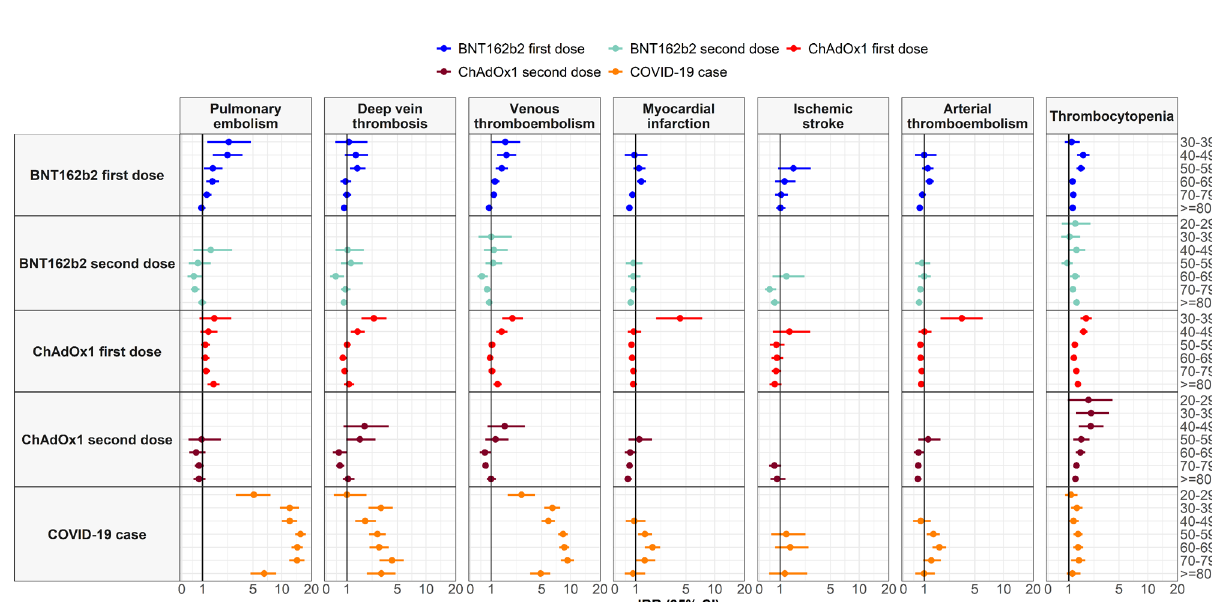
Fig.4|ExpectedversusobservedeventsamongthosevaccinatedagainstSARS- CoV-2 and those with a SARS-CoV-2 infection. Expected events for each of the study cohorts based on indirect standardization using rates from the general population between 2017 and 2019 are compared with the number of observed